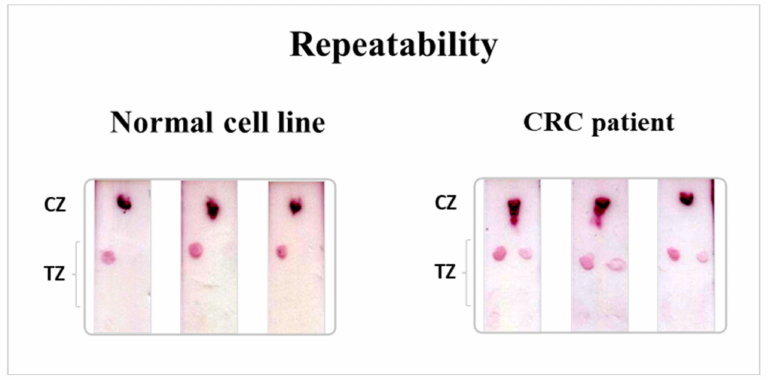
Figure 6. Repeatability of the multiplex strip test for the normal cell line and the blood sample of a CRC patient. TZ: test zone, CZ: control